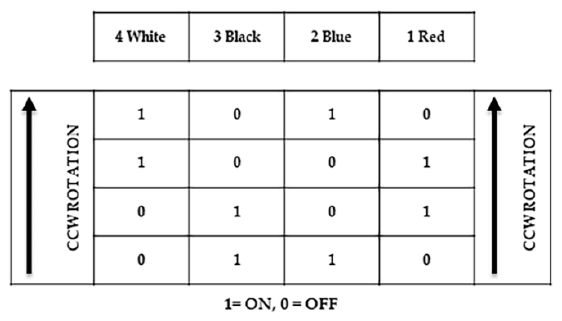
Figure 9. Truth values for the motor.